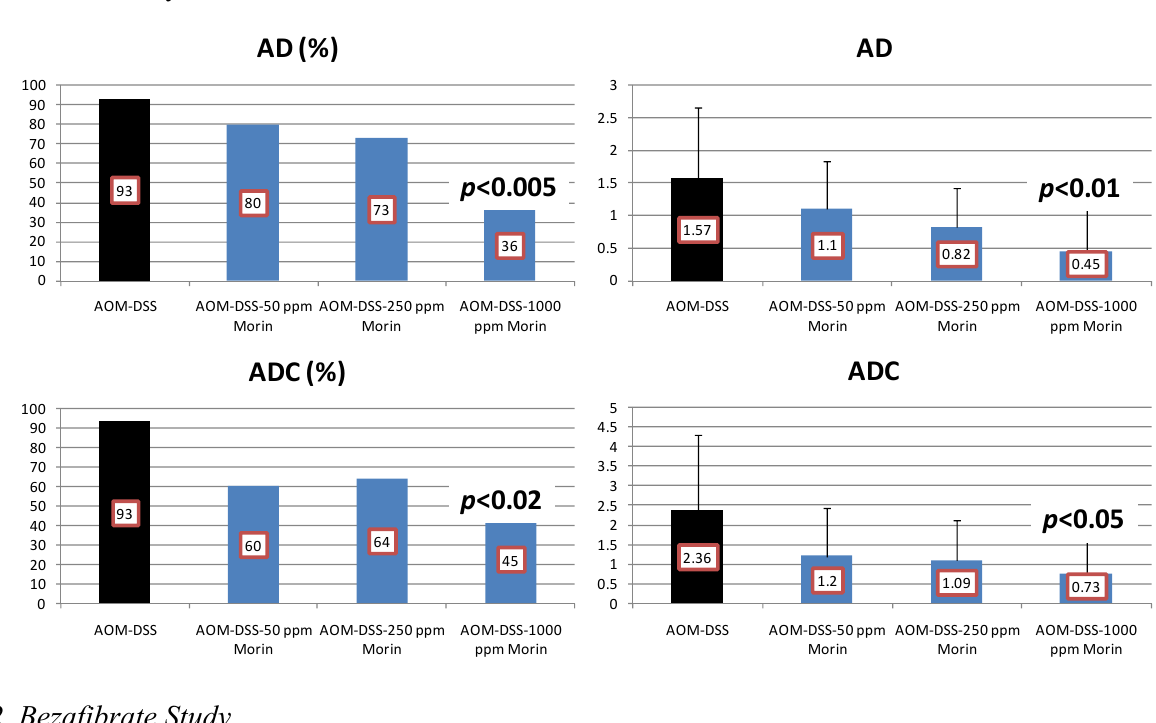
Figure 4. Incidences and multiplicities of adenoma (AD) and adenocarcinoma (ADC) in the morin